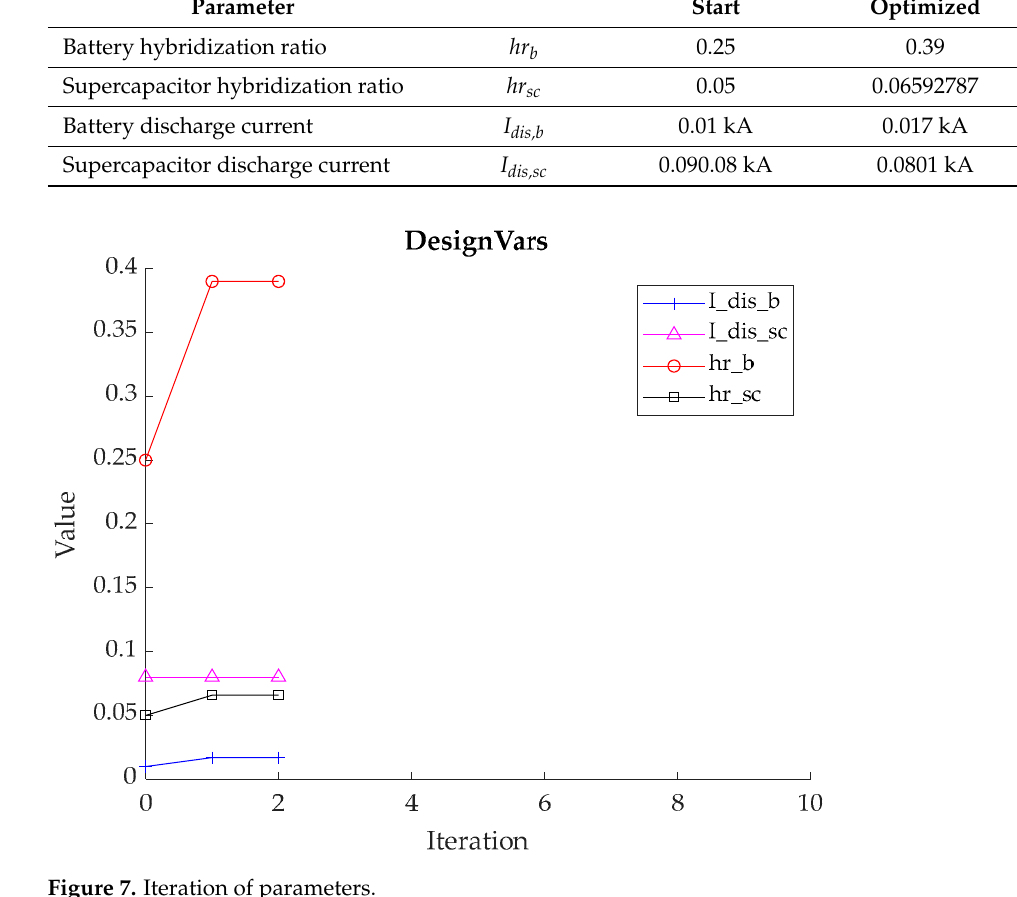
Figure 7. Iteration of parameters. Table 3. Optimized